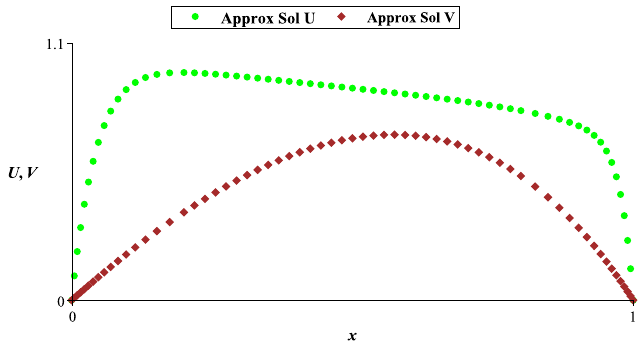
Figure 2. Numerical solution of Example 4 for (cid:15) = 2 − 8 , using (SCA) and N = 64 on non-uniform mesh. The solution interval is divided as [0 , σ ] ∪ [ σ, 1 − σ ] ∪ [1 − σ, 1]. The